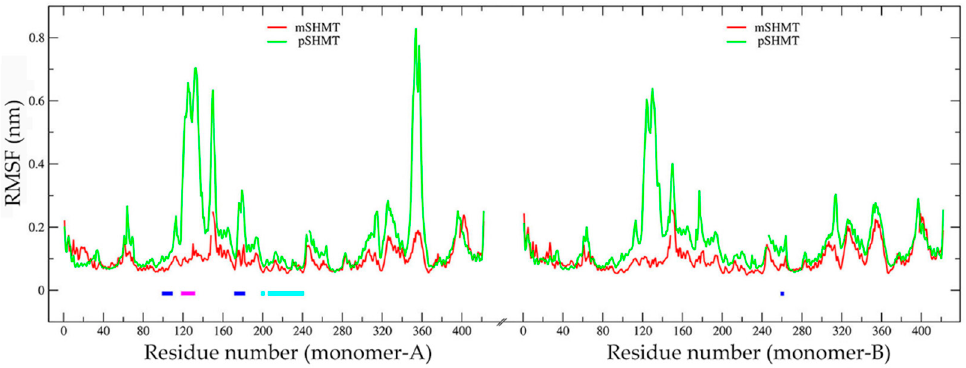
Figure 3. Per-residue C α Root-mean-square fluctuation (RMSF) profiles of mSHMT (red line) and pSHMT (green line). Residues that constitute the “floor” (residues 197–204 and 213–242), “walls” (inner “wall”: residues 97–110 from the monomer-A and 258–264 from the monomer-B; outer “wall”: residues 174–182 from the monomer-A), and “roof” (residues 118–133) of the active site in the monomer-A are indicated above the horizontal axis by line segments colored in cyan, blue, and magenta, respectively.